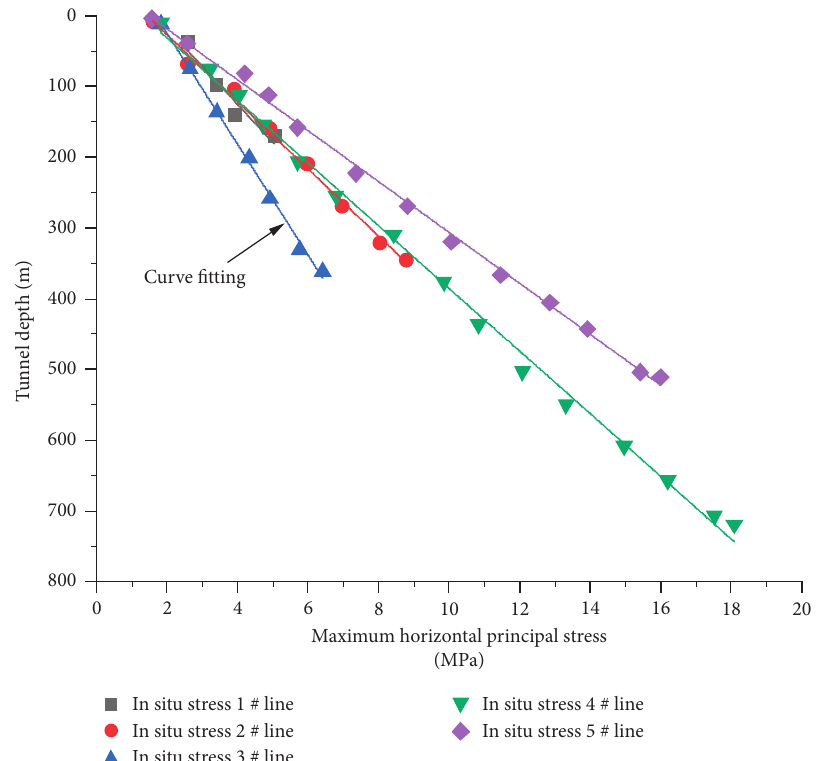
Figure 2: Variation characteristics of maximum horizontal in situ stress with